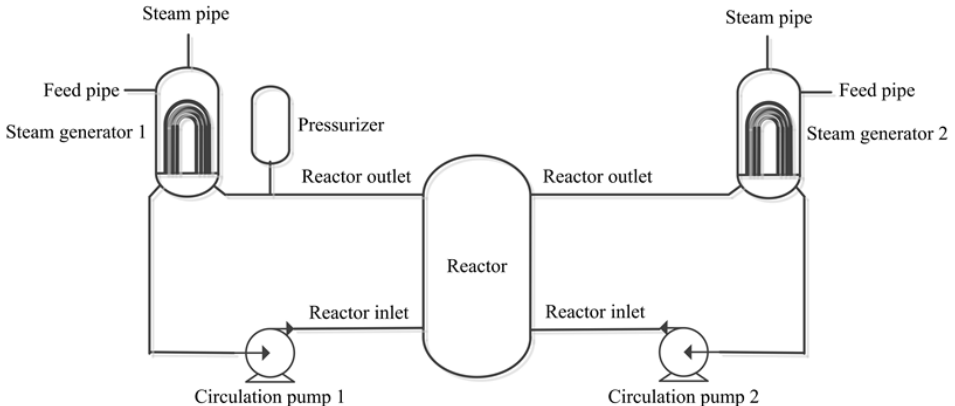
Figure 2. Simplified diagram of a PWR marine nuclear power plant.